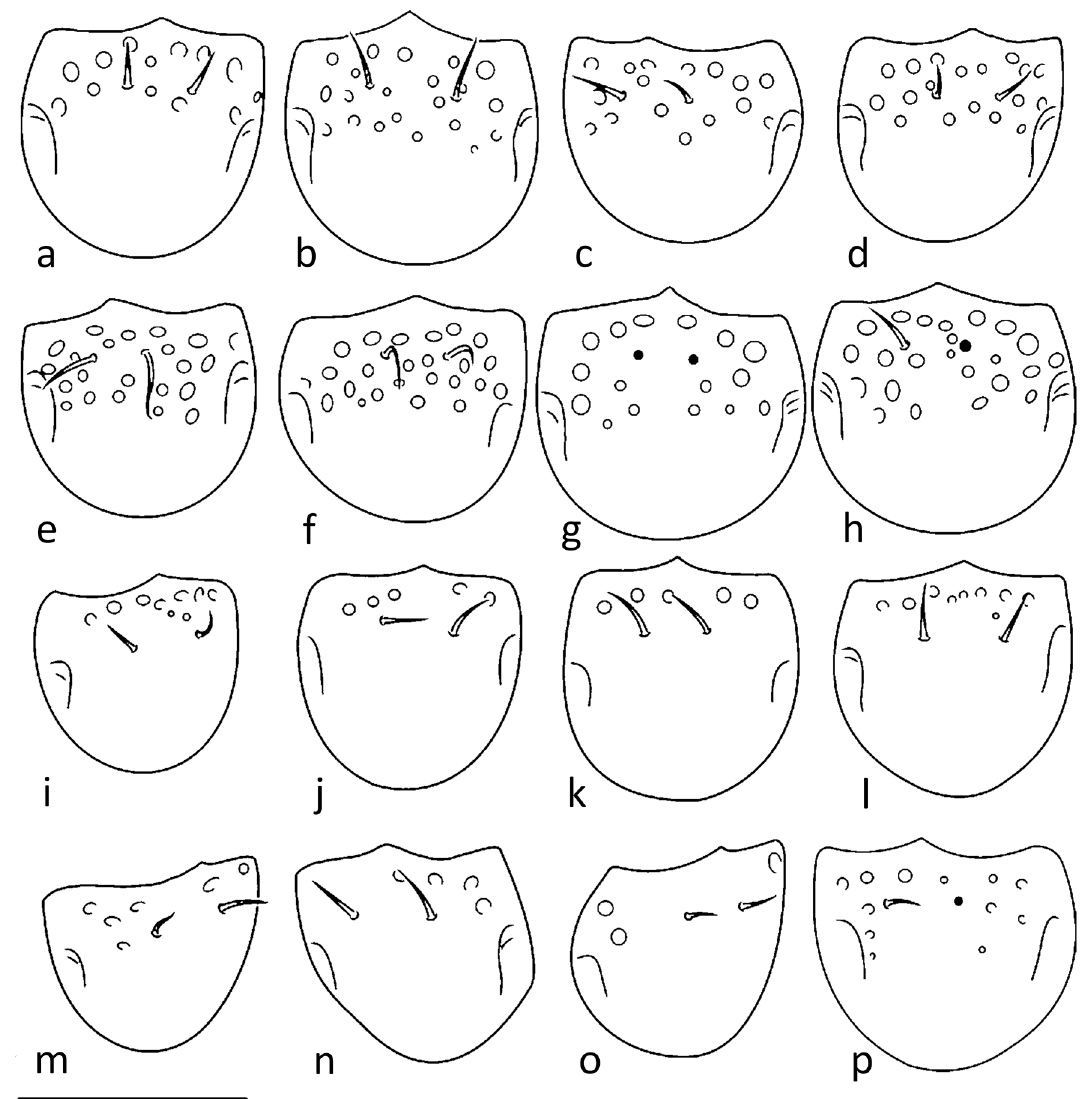
Figure 5. Inter- and intraspecific variation of foveae on mentum of different Caleremaeus species; some menta in ventrolateral view. ( a – d ) Caleremaeus mentobellus : ( a ) Peggau, ( b ) Klafferbach valley, ( c ) Deutschlandsberg, ( d ) Lučice (HR); ( e – h ) C. elevatus : ( e , f ) Murau, ( g ) Bad Ischl, ( h ) Burg Eltz (D); ( i – l ) C. lignophilus : ( i ) Heimschuh, ( j ) Tamischbachgraben, ( k ) Scheiblalm, ( l ) Pontebba (I); ( m – p ) C. alpinus : ( m – o ) Handalpe, ( p ) Saualpe; scale bar = 50